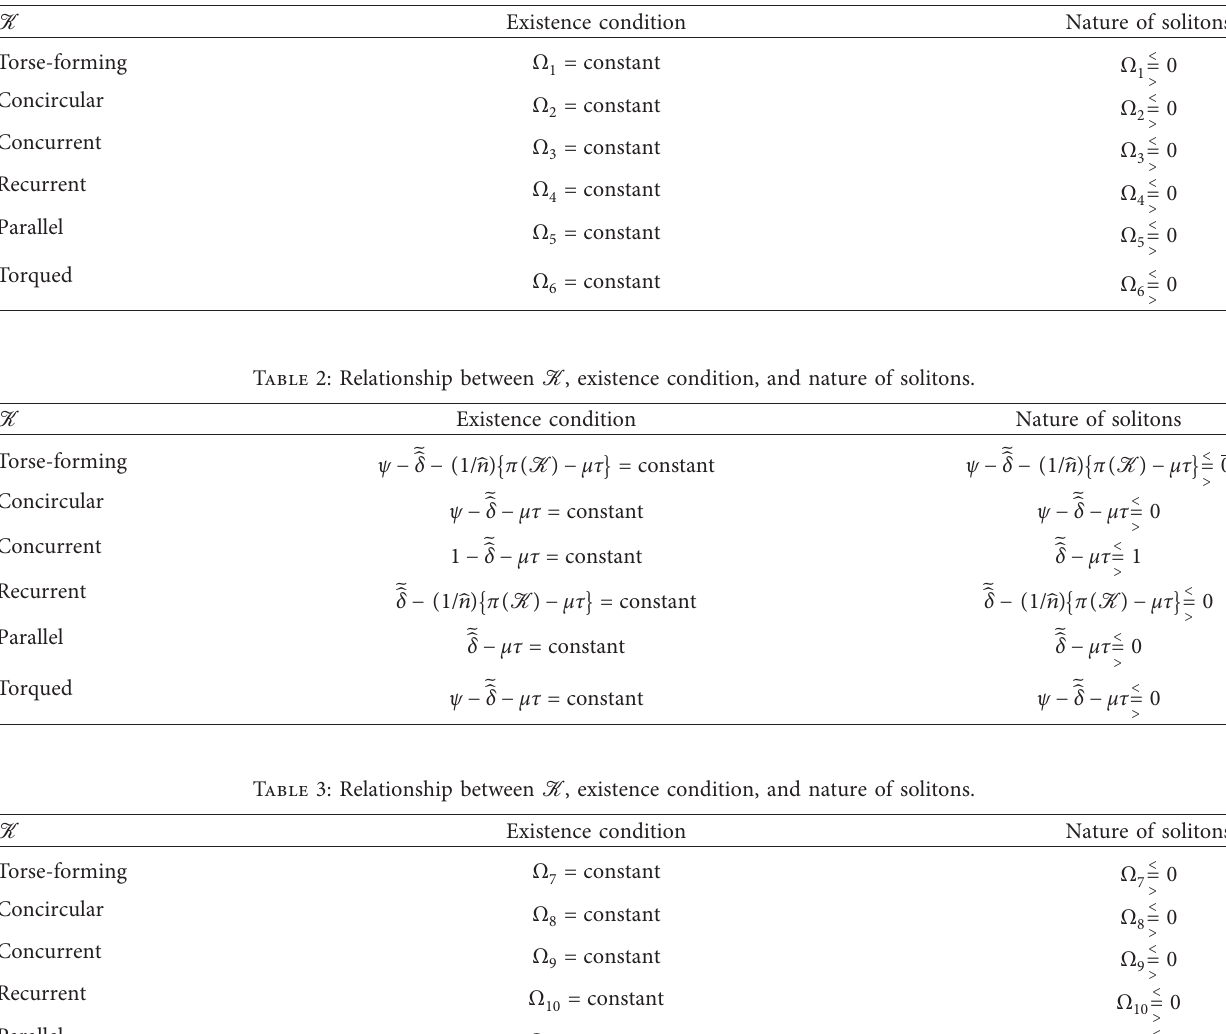
Table 1: Relationship between K , existence condition, and nature of solitons.